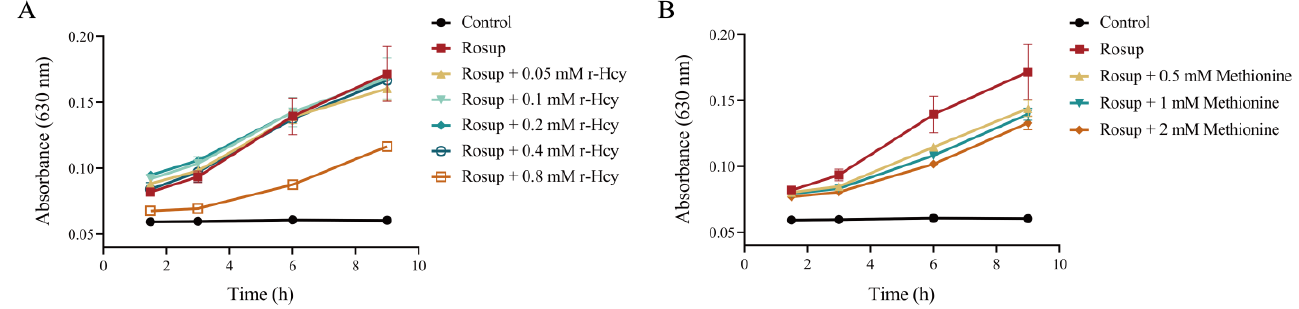
Figure 5. Effects of r-Hcy and methionine on MetHb formation in Rosup-treated erythrocytes ( n = 3). The absorbance at 630 nm represented the content of MetHb. ( A ) r-Hcy (0.8 mM) treatment for 3~9 h significantly inhibited MetHb formation induced by Rosup. ( B ) Treatment with 0.5~2 mM methionine for 6~9 h significantly decreased formation of MetHb in Rosup-treated erythrocytes. 3.8. The Alterations of Total-Hcy and GSH Levels in Erythrocytes after Treatment with Rosup